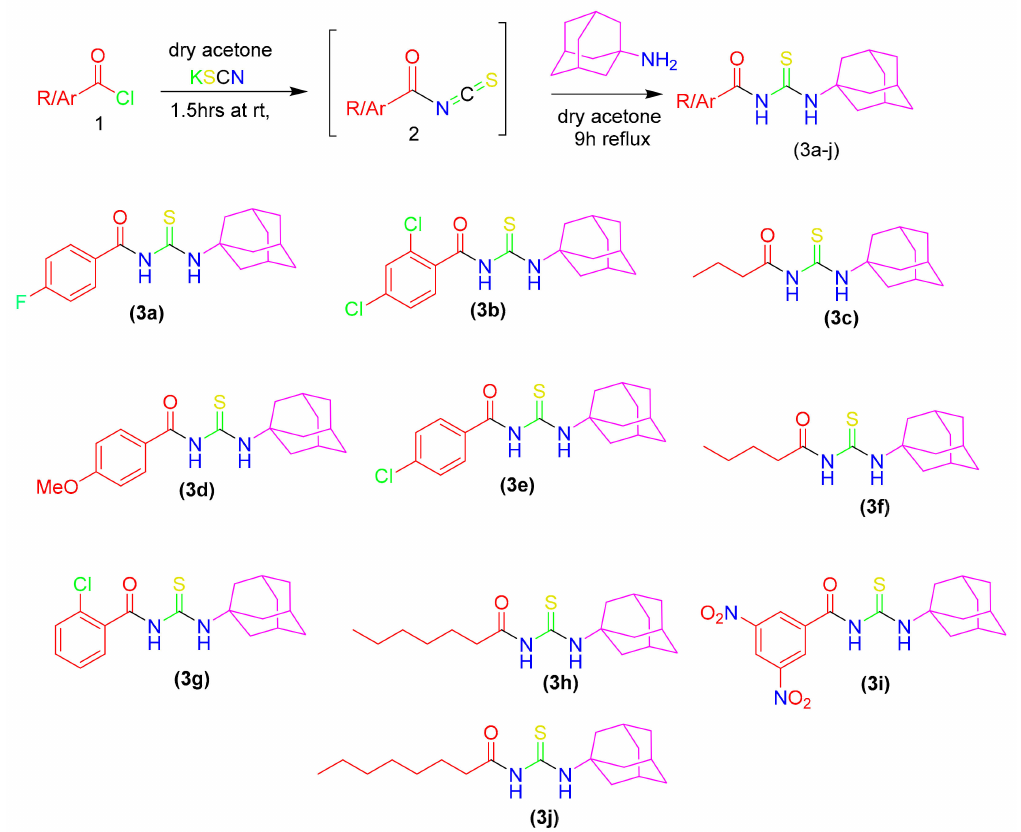
Figure 2. Synthetic scheme and molecular structures of synthesized